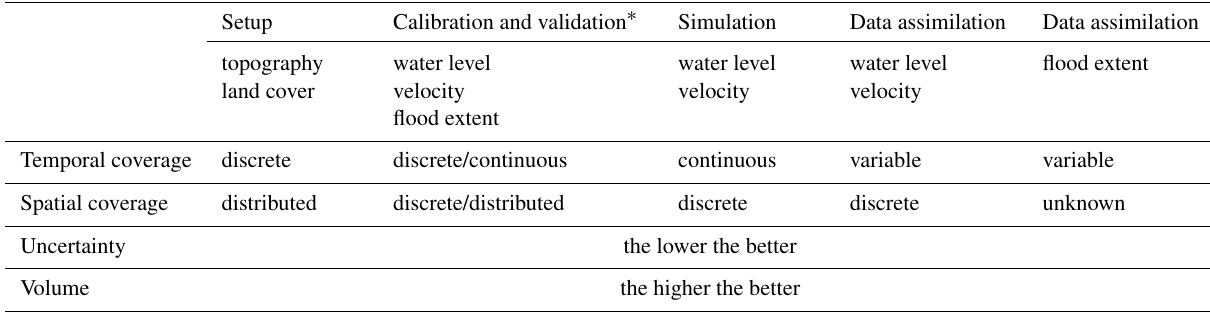
Table 6. Data properties currently required in the modelling